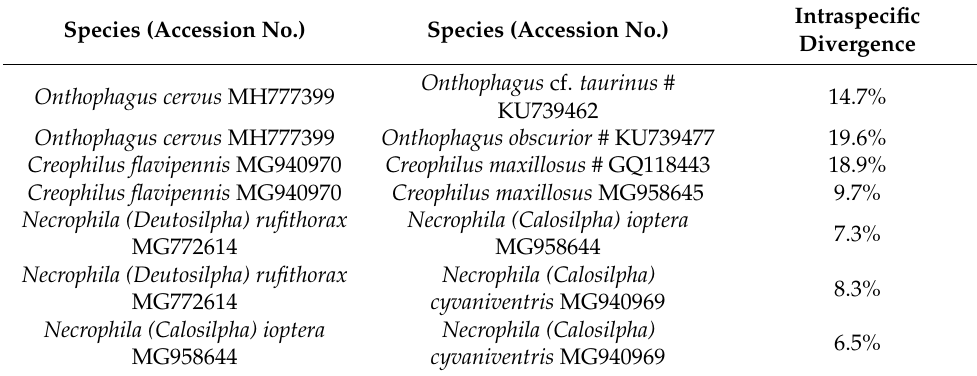
Intraspecific Divergence